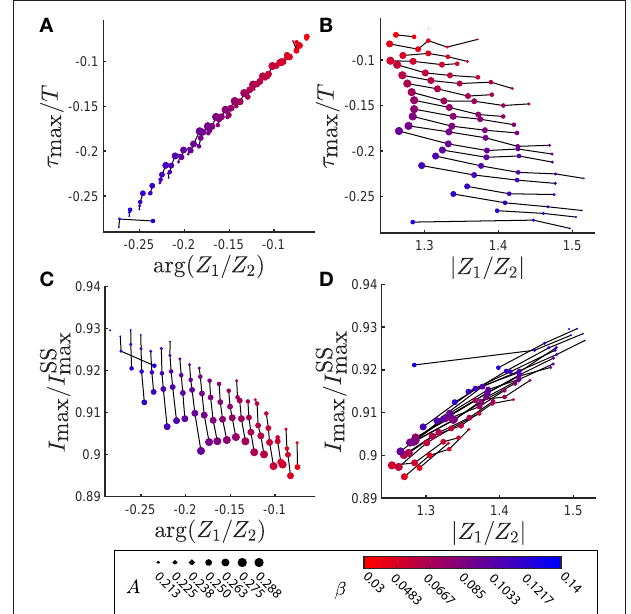
FIGURE 3 | Dependency of ( I max , ν max ) on the synchronization level and on the parameters β and A . (A) The maximizing time delay τ max has a nearly linear dependency on the angular phase difference of order parameters arg ( Z 1 / Z 2 ). (B) τ max appears largely independent of the ratio of the magnitude of order parameters | Z 1 / Z 2 | , though results are weakly dependent on β . (C,D) The normalized maximum peak of mutual information I max / I SS max shows a weak dependency on the ratio of order parameters. All other parameters are fixed at σ ω = 0.01, σ C = 0.01, σ 2 W =